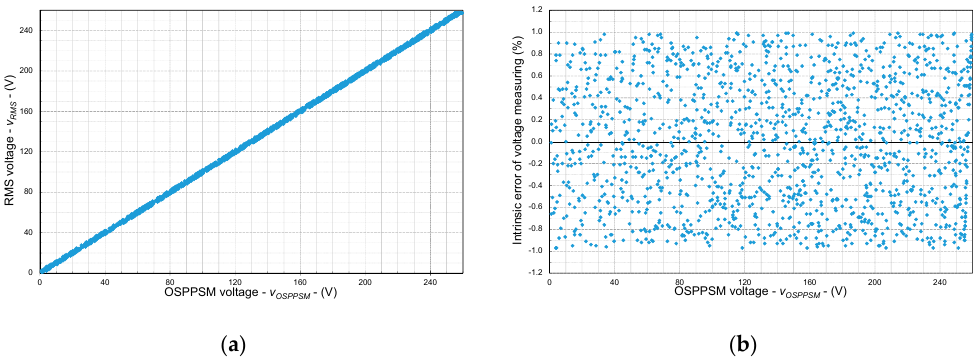
Figure 13. Voltmeter test: ( a ) OSPPSM vs. RMS voltage. ( b ) Intrinsic error of voltage measuring.